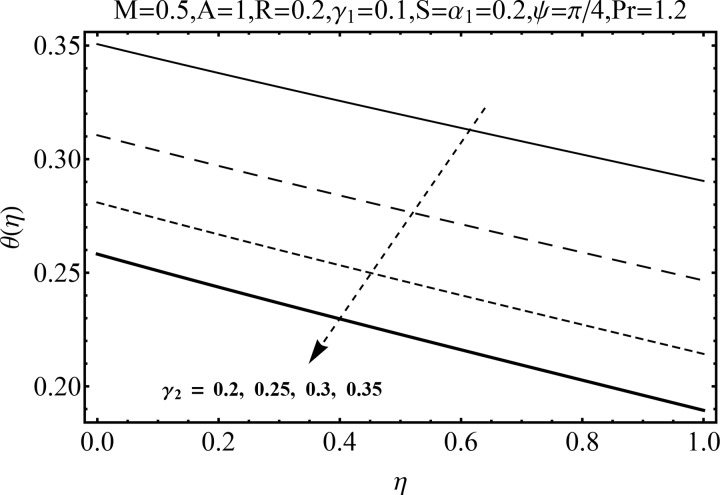
Influence of γ2 on θ(η).